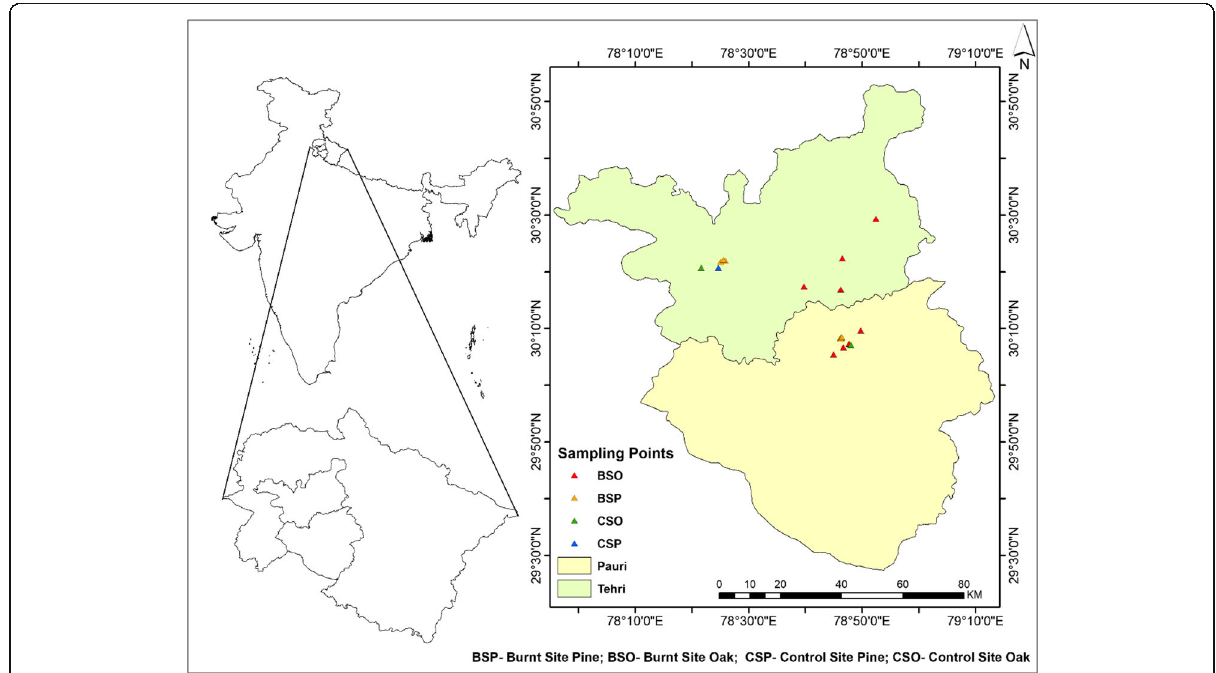
Fig. 1 Soil sampling locations in oak and pine forests of Tehri and Pauri Garhwal districts in Uttarakhand,